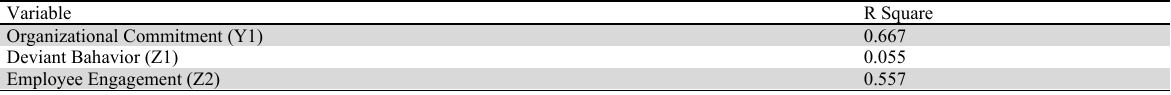
Structural Model Testing